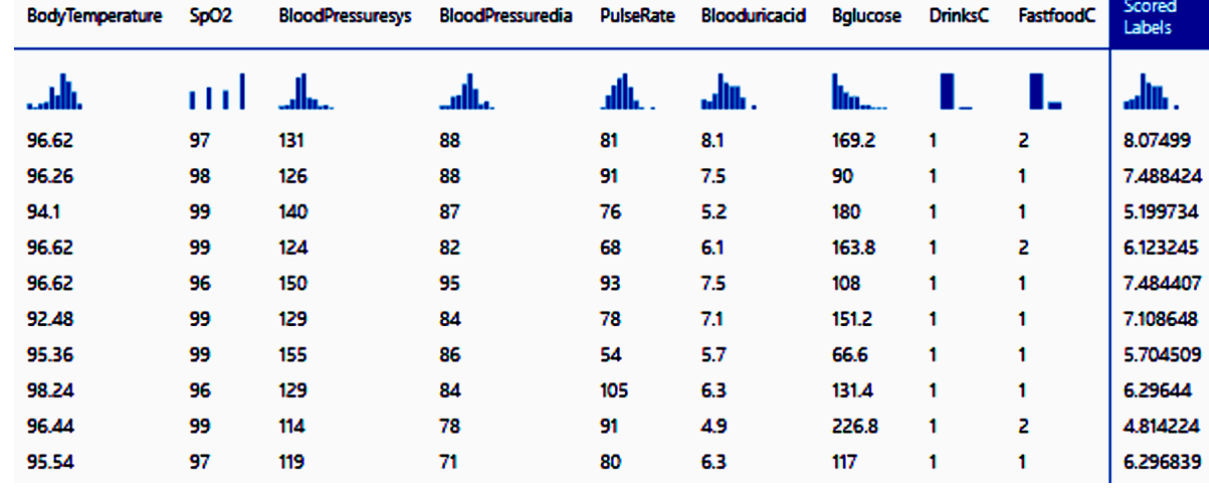
Figure 2. Partial view of the score model obtained by the boosted decision tree regression. Scored labels is the result column in this scoring result. The numbers are the predicted blood uric acid value for each